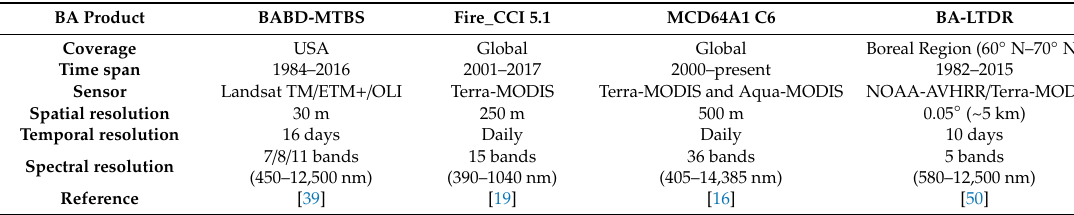
Table 2. Burned area (BA) products analyzed in this study: Burned Areas Boundaries Dataset—